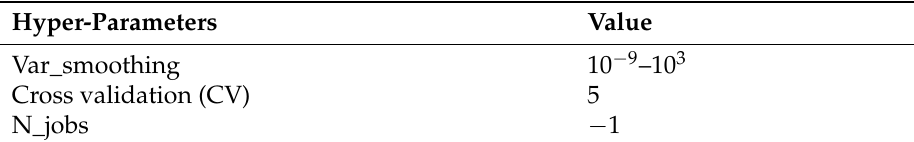
Table 8. Input Parameters for GNB.